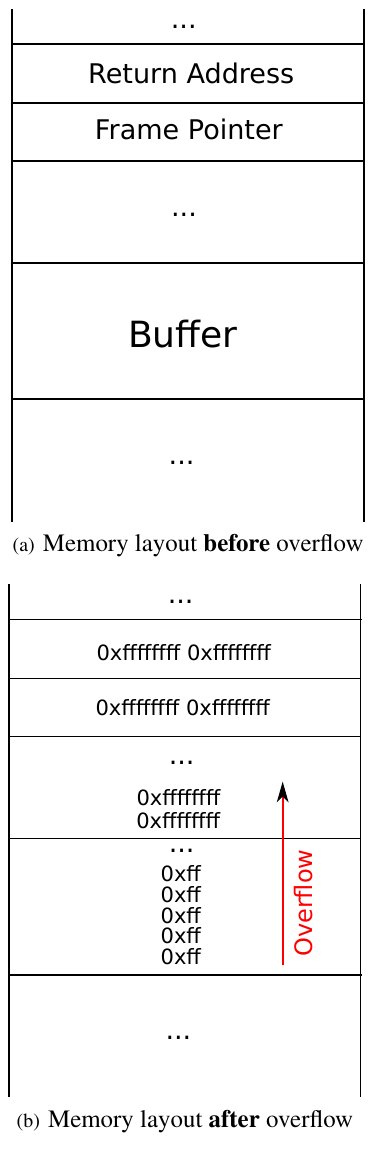
Figure 5. Memory layout of the exploit framework described by listing 11 (without the usage of any security mechanism) before and after initiation of a simple exploit.